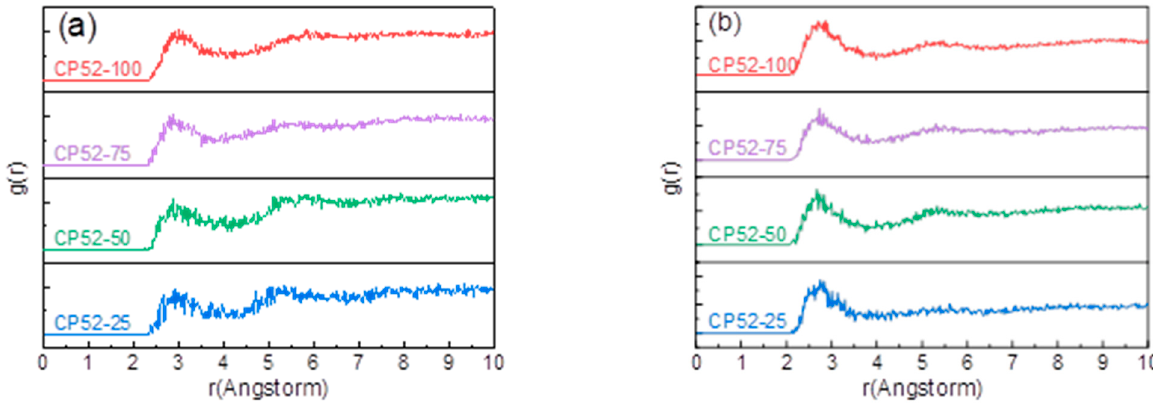
Figure 5. The radial distribution function ( a ) Cl-CP-H····NC-NBR. ( b ) CP-Cl····H-NBR-CN.